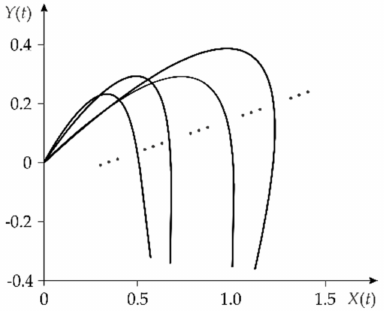
Figure 6. Group of IRNs for the BLDC machine.